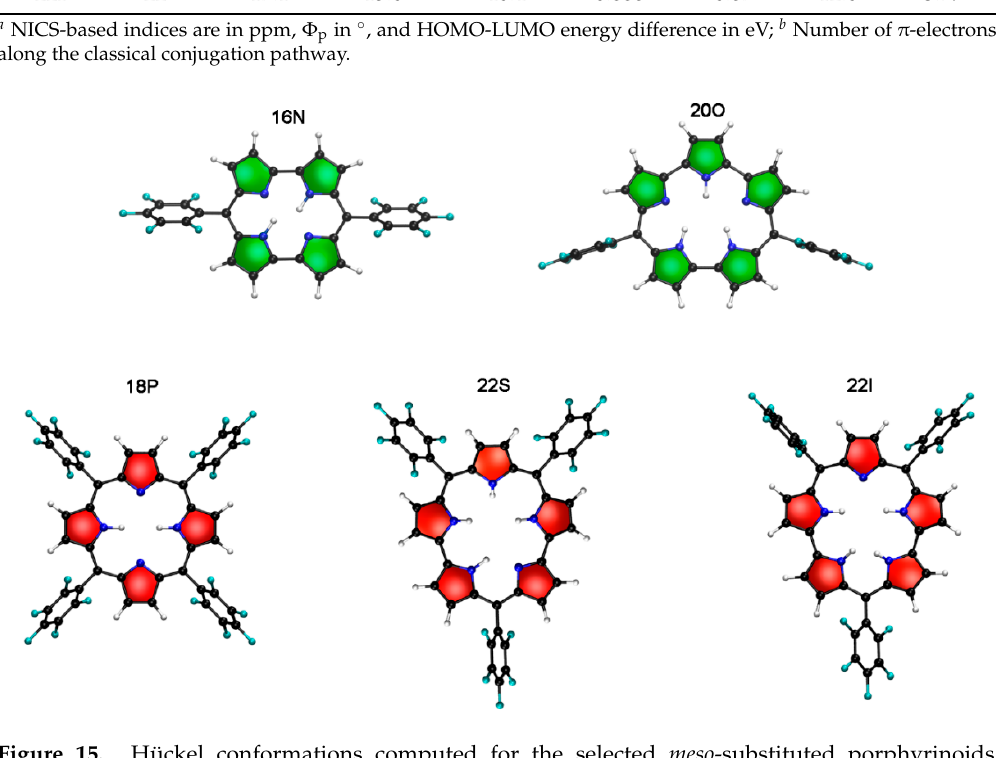
Figure 15. Hückel conformations computed for the selected meso -substituted porphyrinoids. Red five-membered rings are linked to aromatic structures, whereas green ones to antiaromatic configurations.